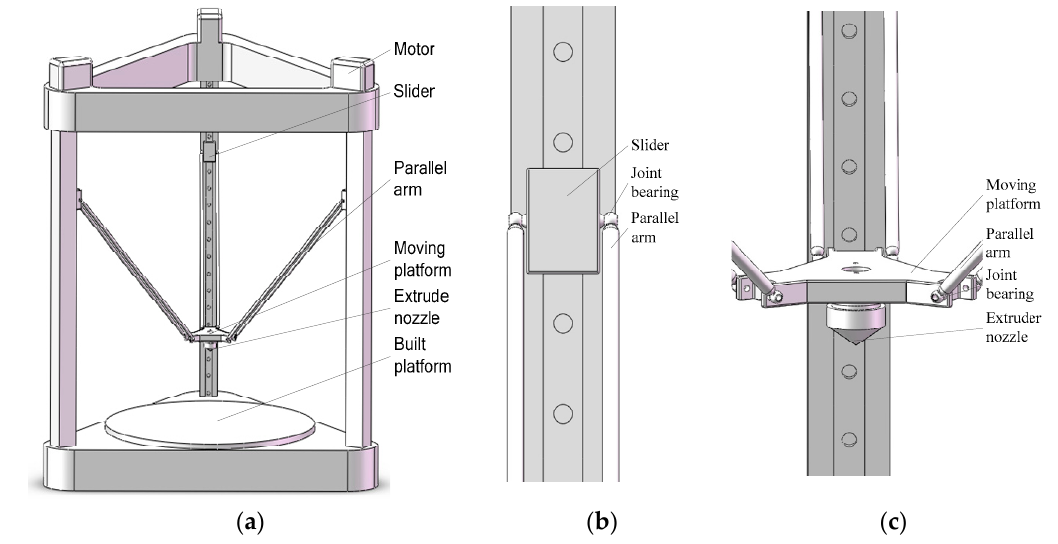
Figure 2. Typical structure of the delta 3D printer: ( a ) over view ( b ) local view of slider ( c ) local view of moving platform.